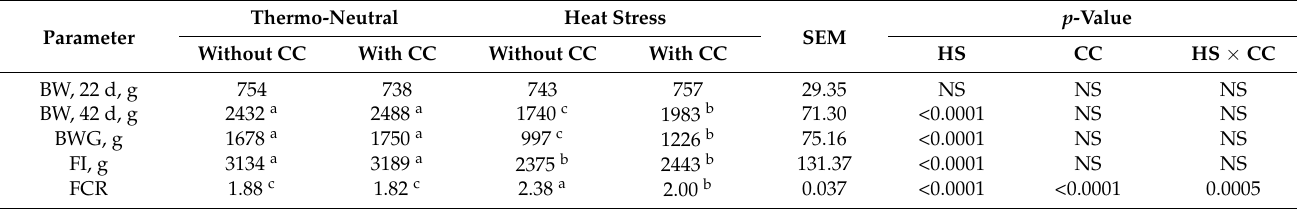
Table 2. Production performance of broilers reared under thermo-neutral (control) or cyclic heat-stress (HS) conditions and with or without Citrullus colocynthis (CC) seeds